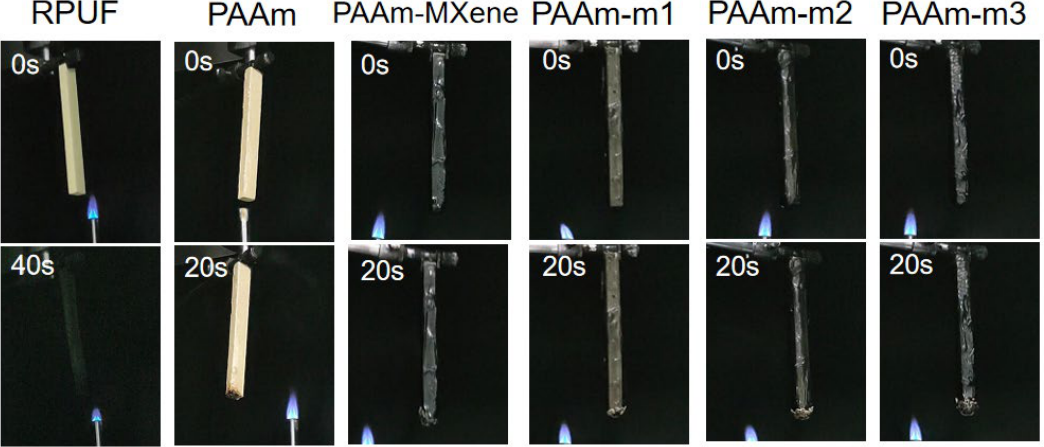
Figure 7. Optical photographs of pure RPUF and Coated RPUF samples before and after UL-94 testing.